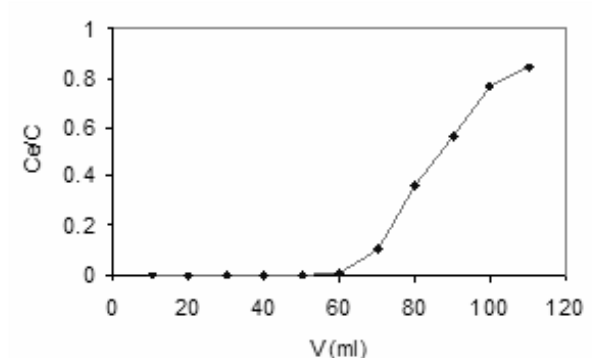
Figure 14. Breakthrough curves obtained for adsorption of lead ion by PANi/SD